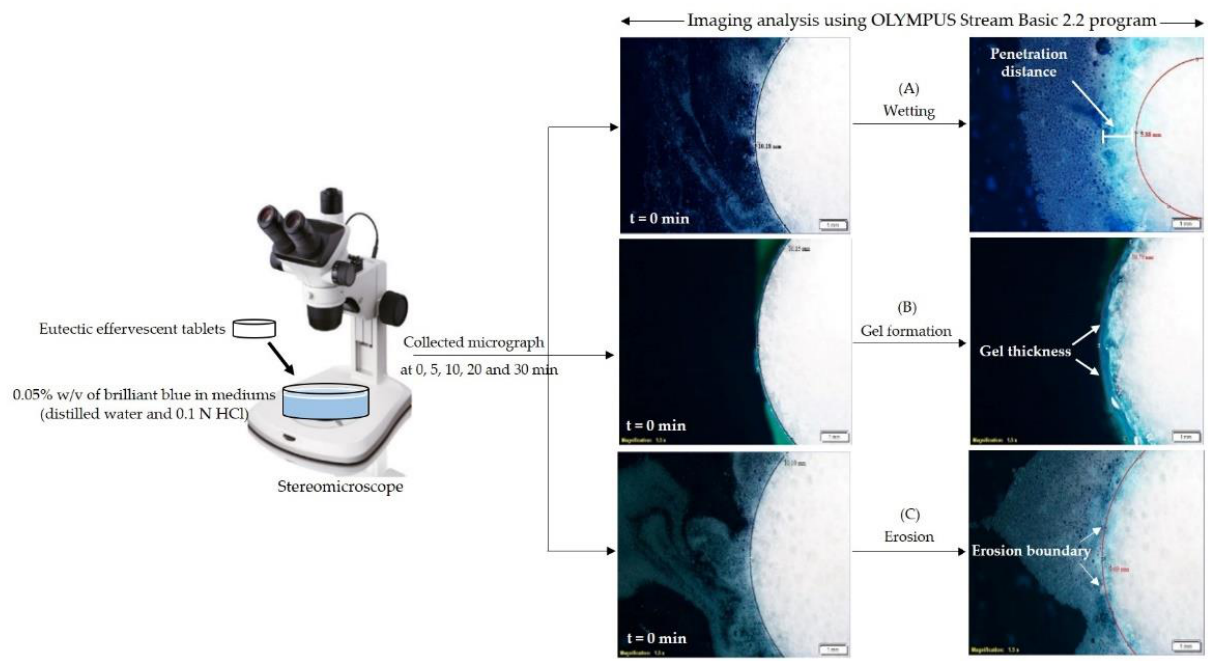
Figure 1. Wetting properties, gel formation and erosion investigation of eutectic effervescent tablets under stereomicroscope.